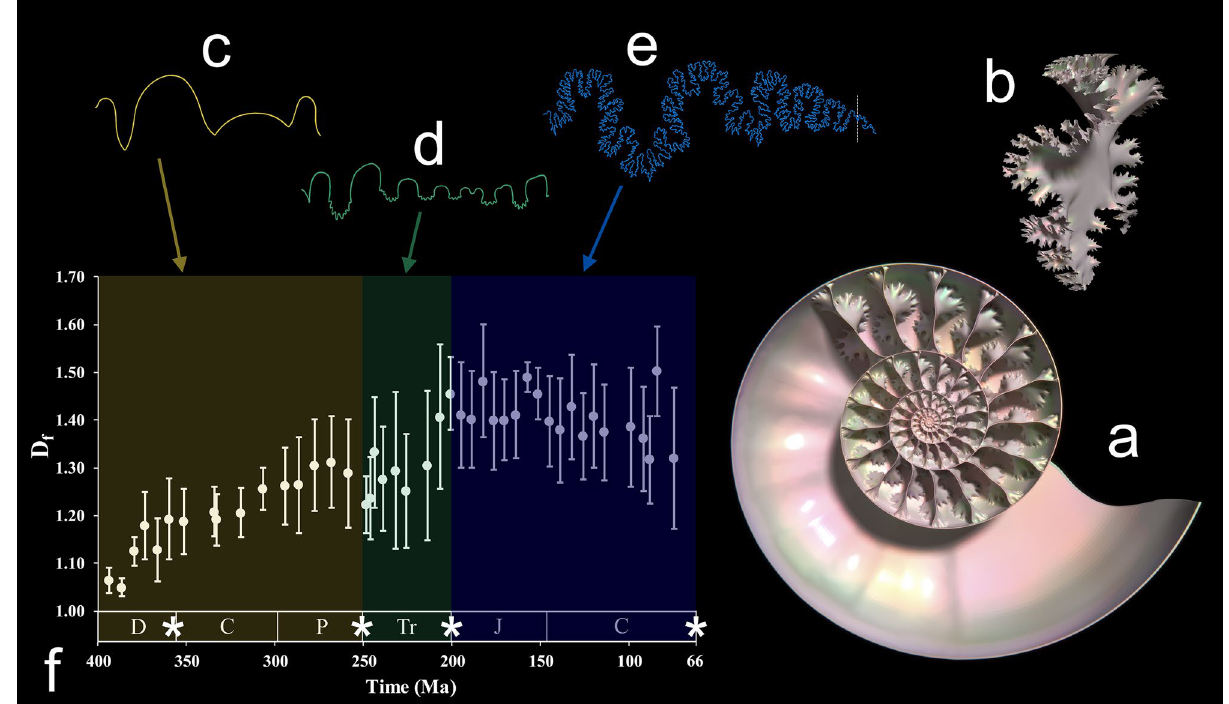
Figure 1. Change in ammonoid cephalopod shell anatomy through time. ( a ) Cross section of a virtually reconstructed ammonoid ( Eopachydiscus marcianus ). ( b ) Septum of the shell in ( a ) showing its frilled margins. ( c ) Goniatitic suture pattern ( Manticoceras ; modified from Arkell et al. 87 ). ( d ) Ceratitic suture pattern ( Otoceras ; modified from Arkell et al. 87 ). ( e ) Ammonitic suture pattern of ( a ) and ( b ). All sutures displayed are only half of the pattern (hemisutures; oriented ventral-left and anterior-upwards). ( f ) Data from Boyajian and Lutz 6 showing increasing sutural complexity (measured by fractal dimension; D f ) through geologic time. Global mass extinctions are indicated with stars on the timeline. The colored regions and corresponding sutures in ( c – e ) represent the dominant suture types during those time